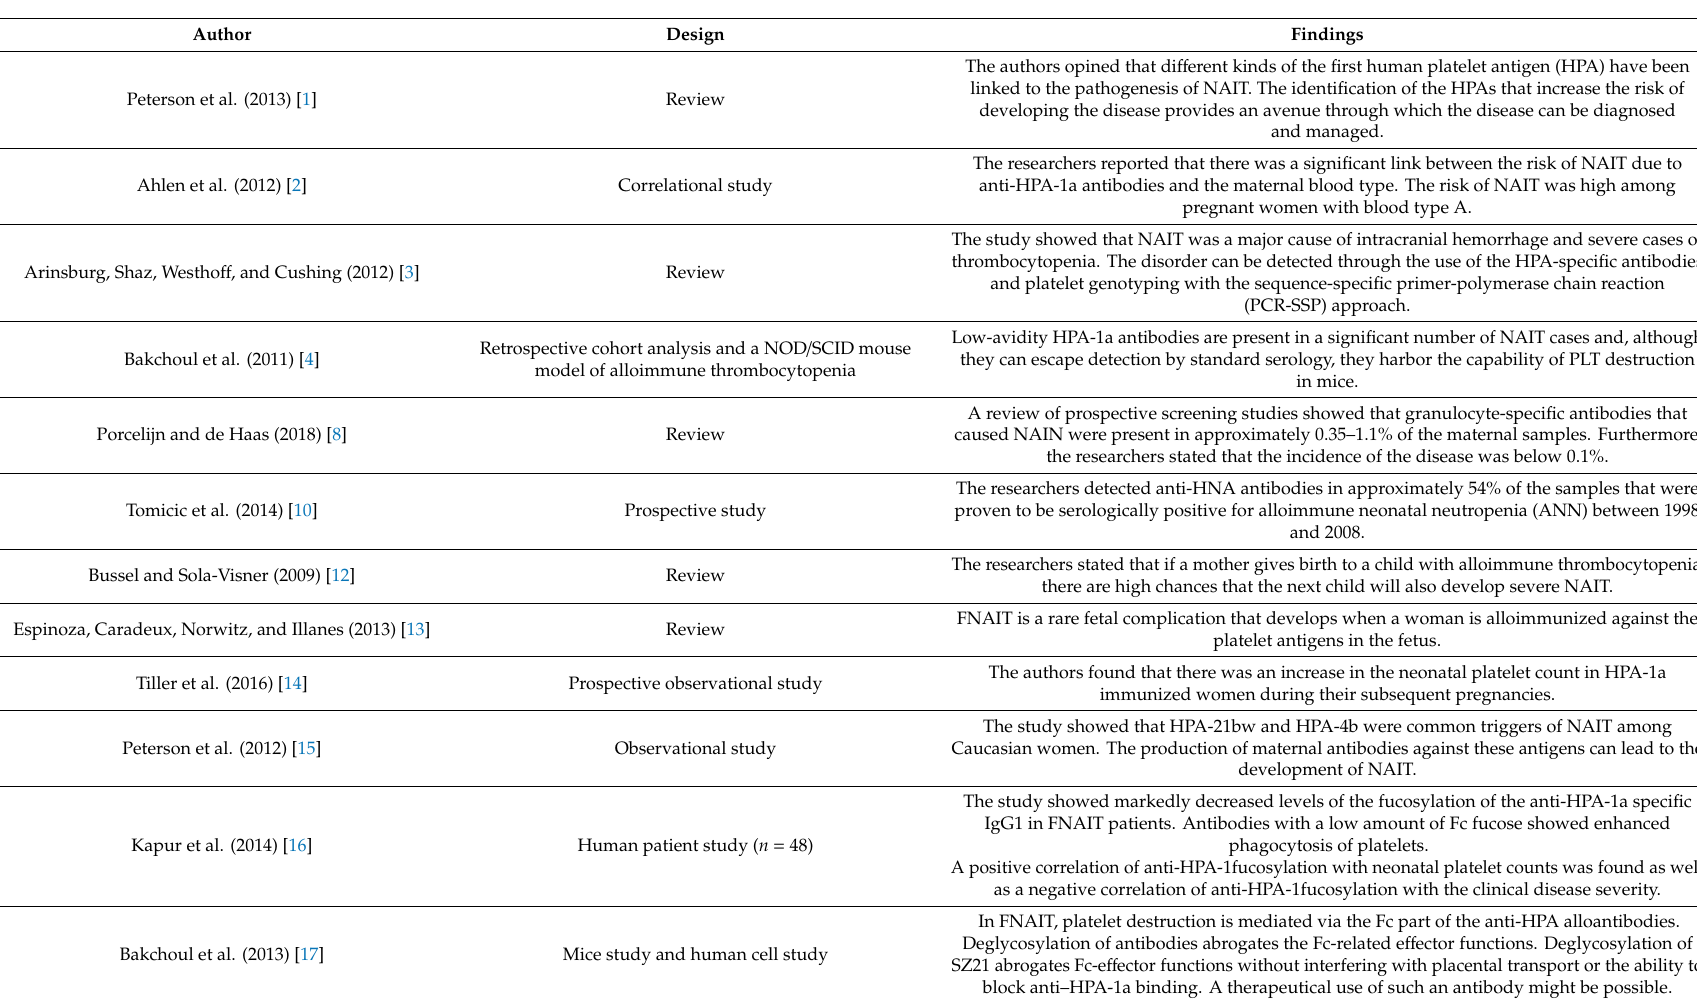
Table 1. Summary of the 23 most important